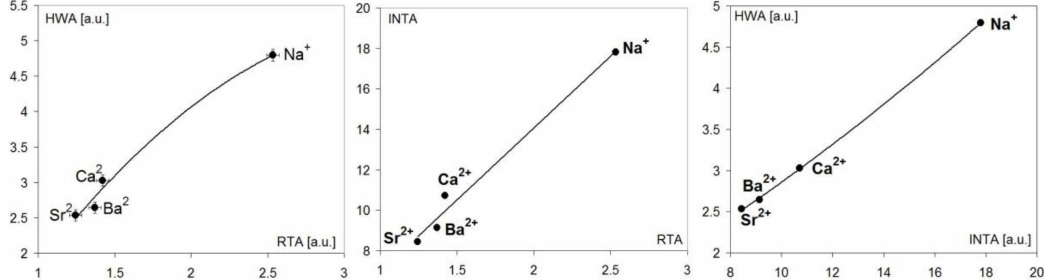
Figure A2. Correlations between HWA, RTA and INTA signal parameters for the tested ions illustrate a possibility of their automatic identification. These parameters are defined as HWA = HW/A, RTA = RT/A, INTA = INT/A, where A is the amplitude, RT—the retention time, HW—the half-width and INT—the integral intensity of the measured signal.